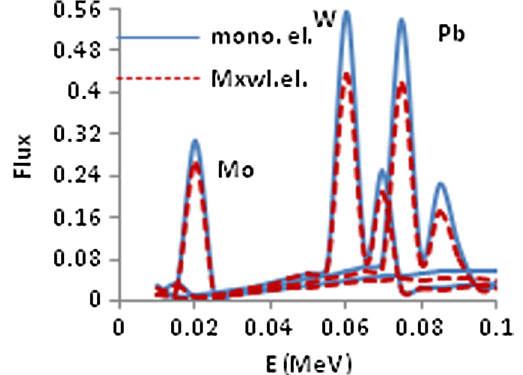
FIG. 6. The x-ray fluxes produced by the q -monoenergetic and the q -Maxwellian electron profiles at the optimum thickness, d opt , of each target; for Mo, W, and Pb, they are 700, 1300, and 1500 (cid:5) m , respectively, by the q -monoenergetic profile and they are 400, 450, and 700 (cid:5) m , correspondingly, by the q -Maxwellian profile.